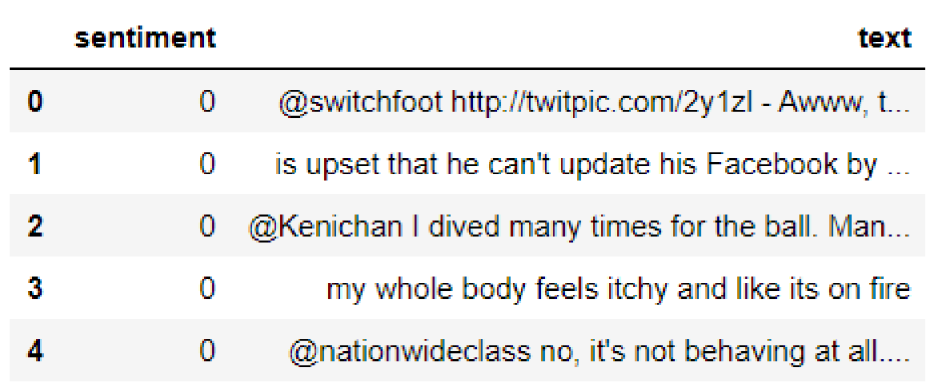
Fig. 7 Data table processing diagram.